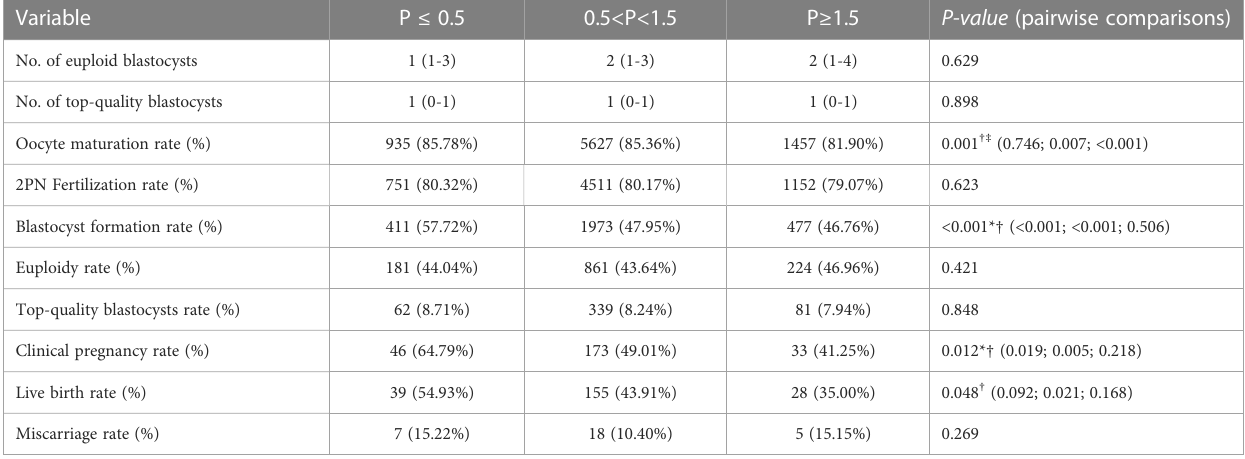
TABLE 2 Cycle outcomes according to the Progesterone level on the day of HCG